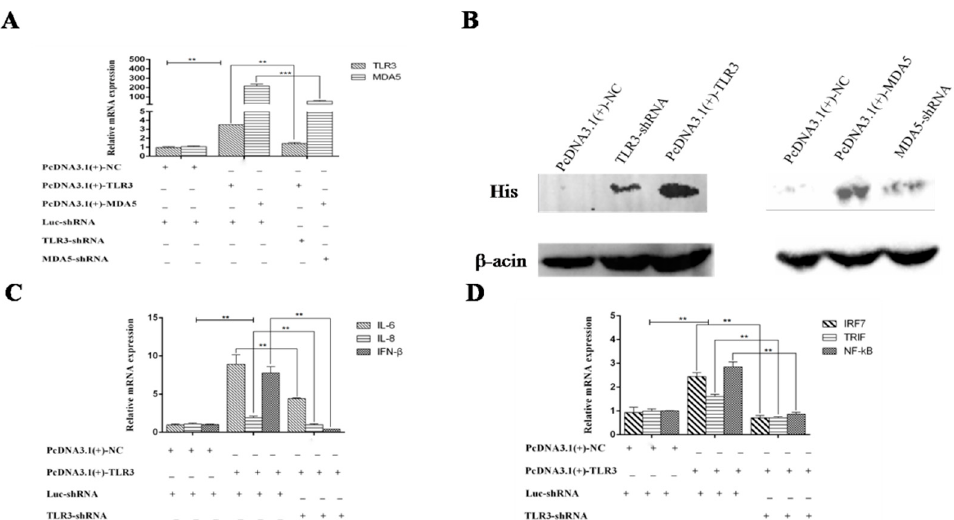
Figure 9. MDA5- and TLR3-dependent signaling pathways play important roles in immunity during DTMUV. DEF cells stably expressing shRNA specifically targeting either TLR3, MDA5, or luciferase control were infected with DTMUV for 36 h. Quantitative real-time PCR and Western blot analysis were then performed to determine interference efficiency for TLR3 and MDA5 ( A , B ). The expression of IL-6, IL-8, IFN- β , IRF7, TRIF, and NF- κ B in DEF cells stably expressing shRNA targeting TLR3 and pcDNA3.1(+)-TLR3 were analyzed by quantitative real-time PCR ( C , D ). In ( A , C , D ) we transfected pcDNA3.1(+)-nc and Luc-shRNA as control group, and set them as 1. The average levels from three independent experiments are plotted. The error bars represent the S.E. * P < 0.05, ** P < 0.01.